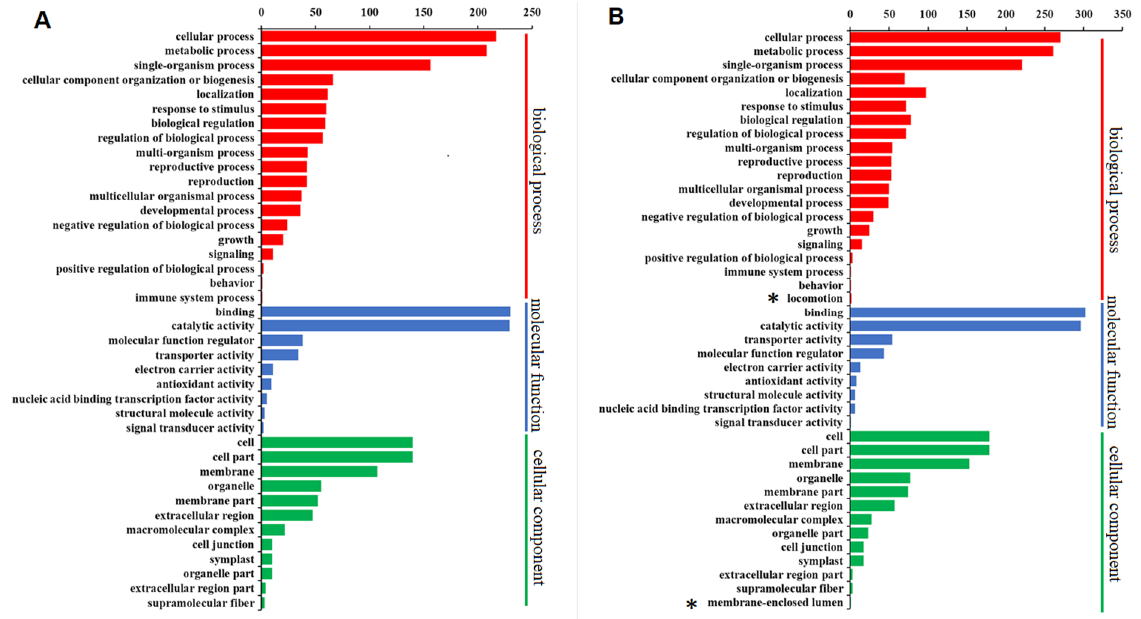
Figure 6. Gene ontology (GO) enrichment analysis and KEGG pathway assignments of MPS and MAS in B73 inbred using Blast2GO. ( A ) GO term enrichment analysis of MPS; ( B ) GO term enrichment analysis of MAS; In ( A , B ) the x -axis indicates the gene number assigned to a GO term and the y -axis is the list of significantly enriched GO terms. These significantly enriched GO terms were selected based on a p -value < 0.05 and FDR < 0.05. GO terms of the categories of biological processes, molecular functions, and cellular components are depicted in red, blue, and green, respectively. The asterisk indicates the two additional GO terms assigned to MAS genes.